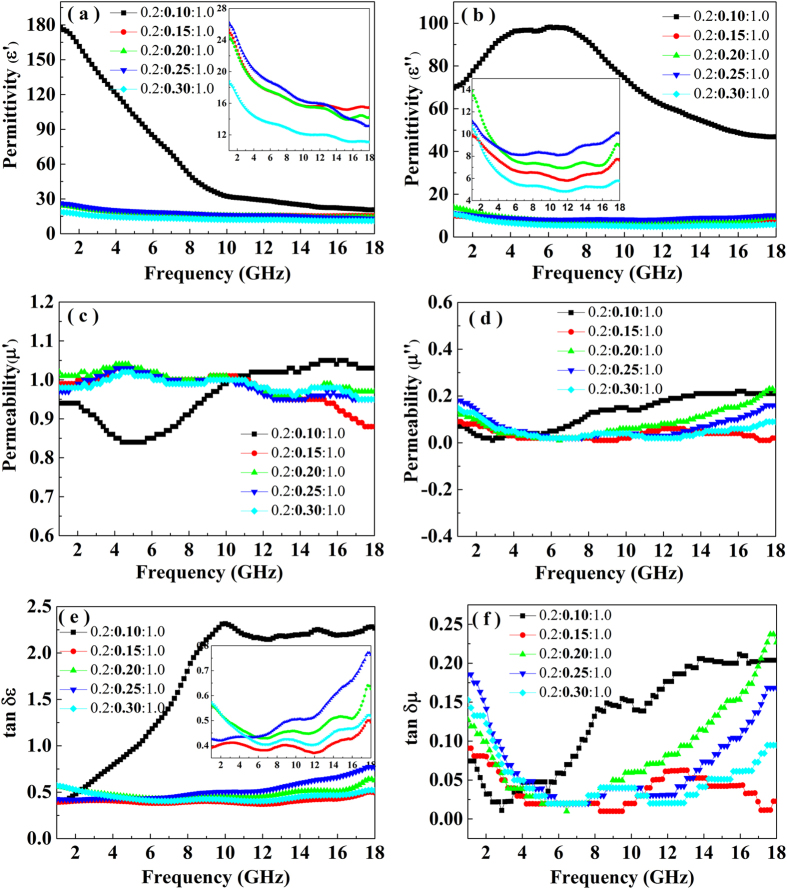
The ε′ (a), ε″ (b), μ′ (c), μ″ (d), tgδε (e) and tgδμ (f) of the BFTO/MCNTs/P3MT/wax composites with different BFTO/MCNTs/P3MT loading.